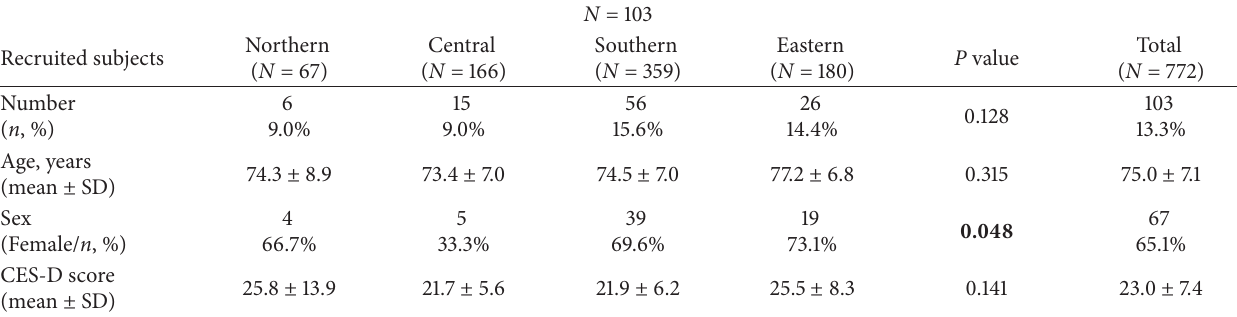
Table 4: Demographic characteristic of participants suspected depression ∗ among aged participants #